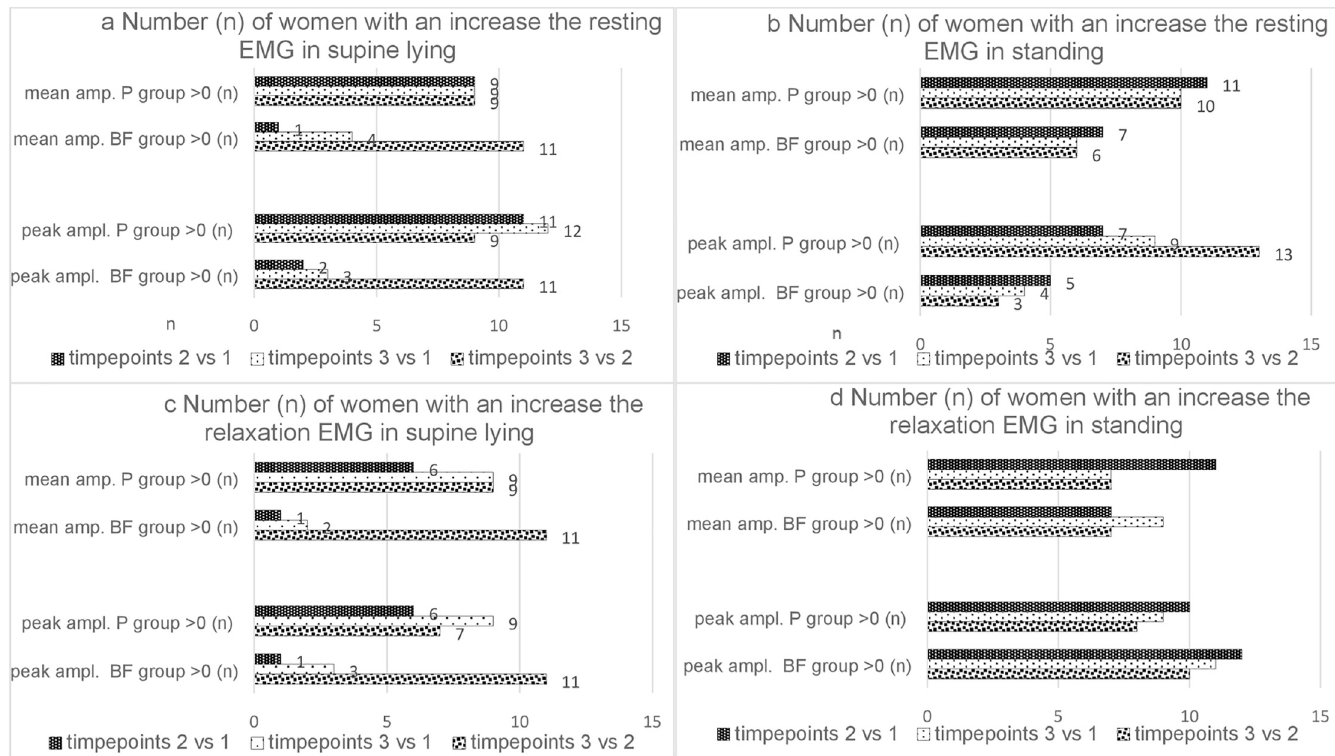
Fig 9. a-d. Intra- and intergroup analysis the number of women with an increase ( > 0 (n)) in the resting activity and 10-second relaxation sEMG; p Chi square test ( χ 2